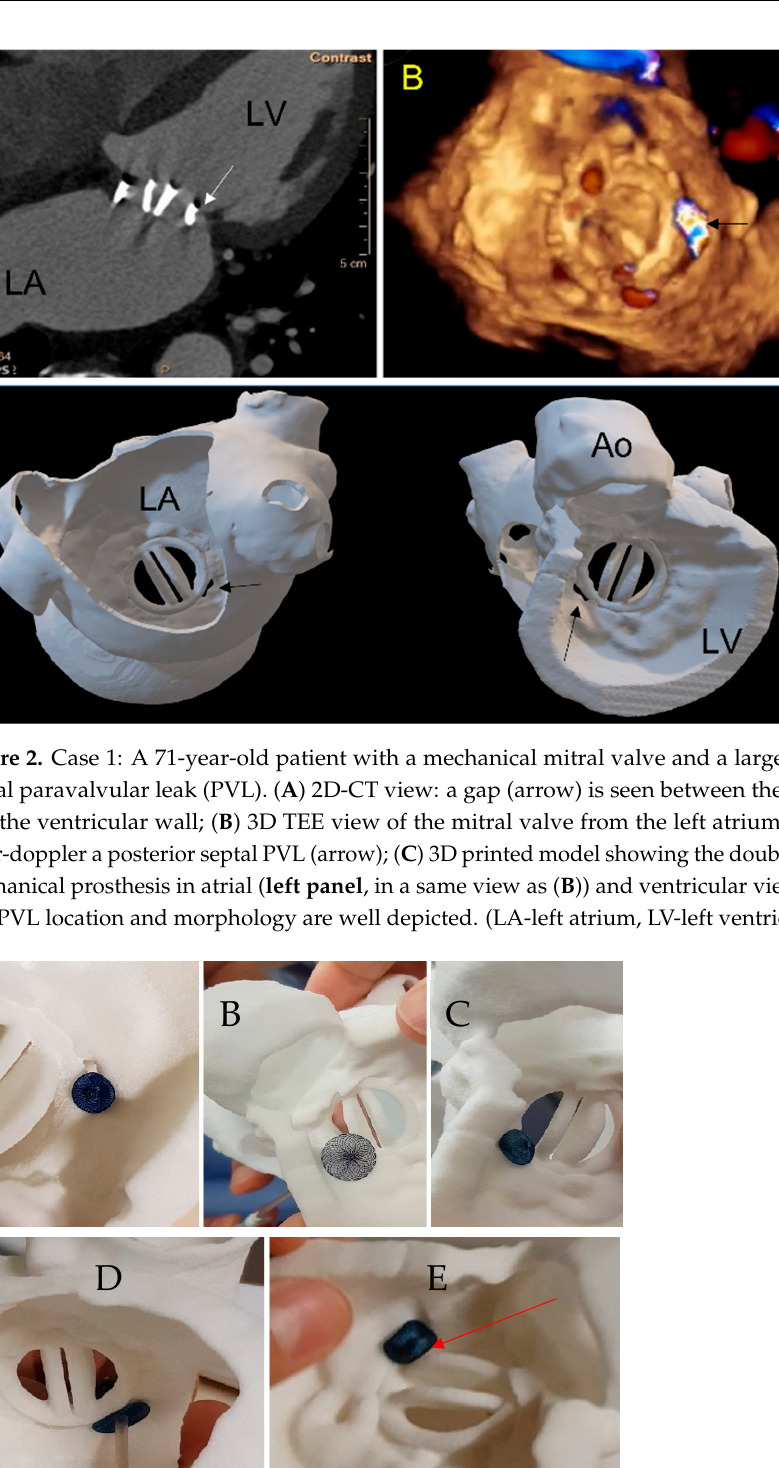
Figure 4. Case 1: per procedural imaging. ( A ) Per procedural 3D TEE in atrial view: Amplatzer Valvular Plug III 3–12 mm blocks the internal prosthetic disc (red arrow); ( B ) traction of the device to adjust its positioning allowing to free the prosthetic disc movements. The position is similar to the simulation on 3D printed model; ( C ) late control CT, good device positioning without leaflet impairment, no residual mitral paravalvular gap, the plug is located as on 3D printed model simulation.